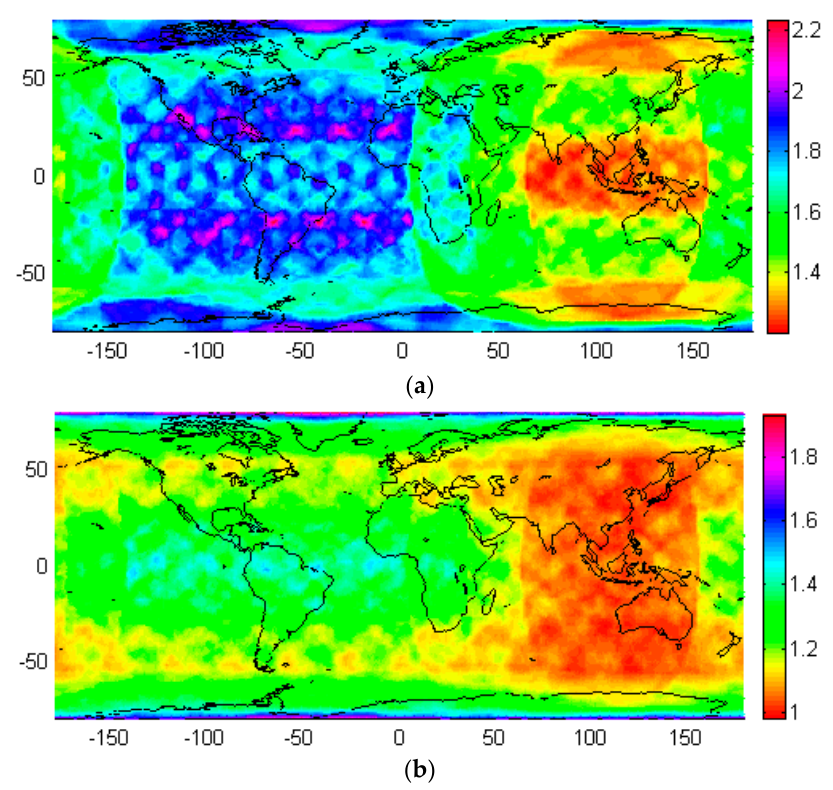
Figure 4. Global distribution for PDOP of BeiDou-3-only ( a ) and BeiDou-3/LEO combined constellation ( b ). Table 6. Statistical results for PDOP.